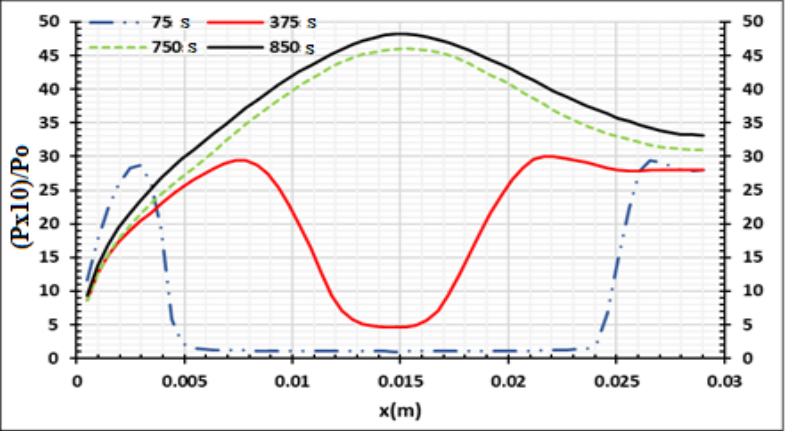
Figure 9. Wood relative pressure distribution at T f = 973.15 K using samples of 30 mm thickness at four process times, ρ bo = 700 kg/m 3 .